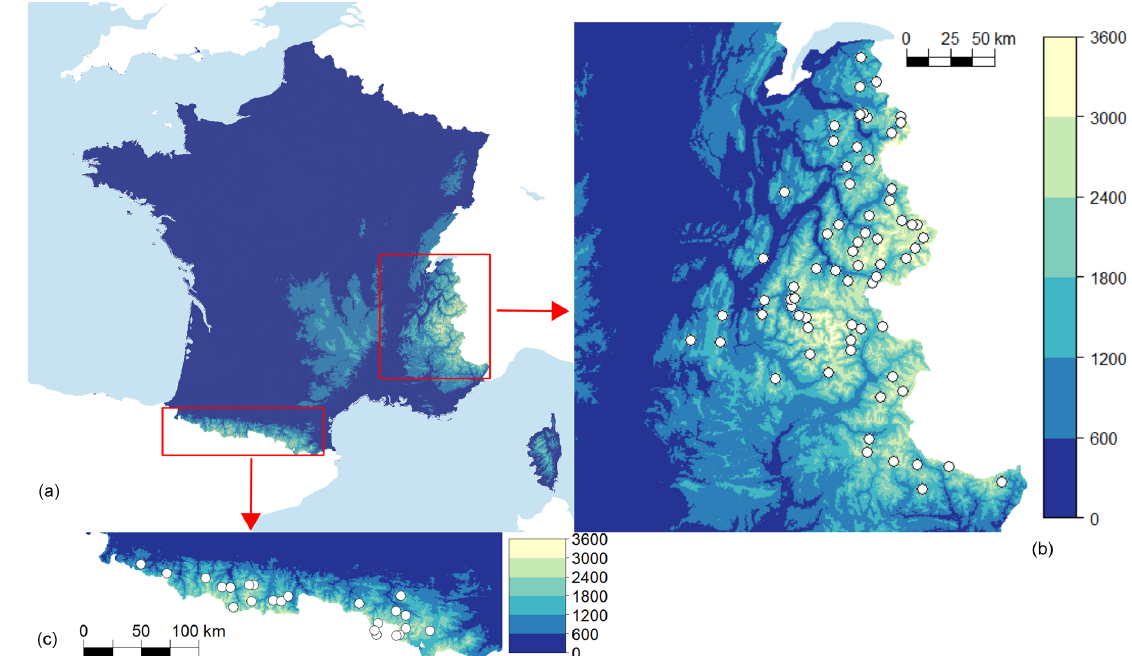
Figure 1. Map of the 92 observation stations (white dots) in the French Alps (b) and Pyrenees (c)